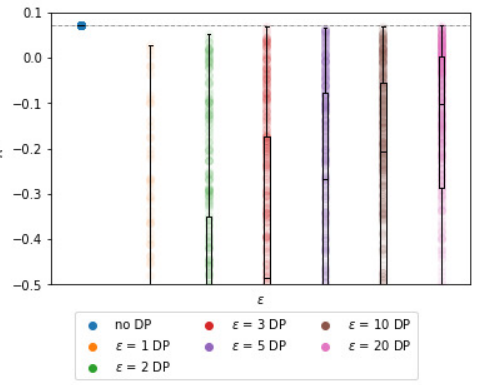
Figure 6. R 2 over ε for the forest fires data set (5 iterations, 100 repetitions, and γ = 1.2).